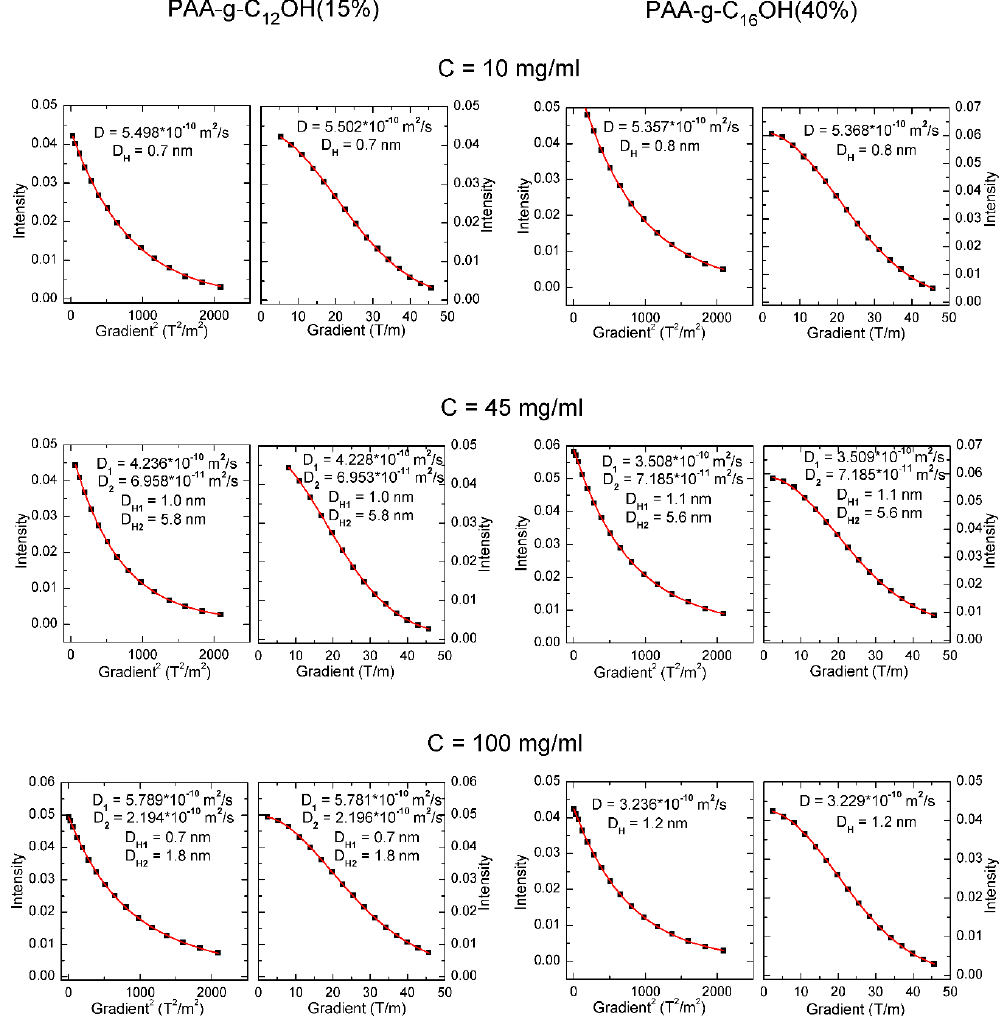
Figure 2. Diffusion coefficients (D) and hydrodynamic diameters (D H ) determined by fitting to appropriate models: G (intensity versus linear gradient) or G 2 (intensity versus square gradient).